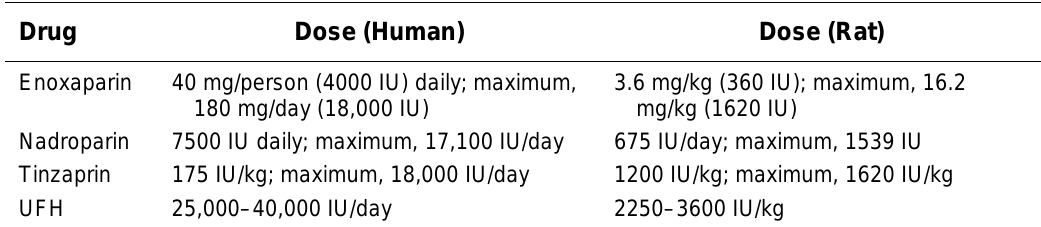
Human Doses of UFH and LMWH Preparations[16,17,18] and Equivalent Doses for